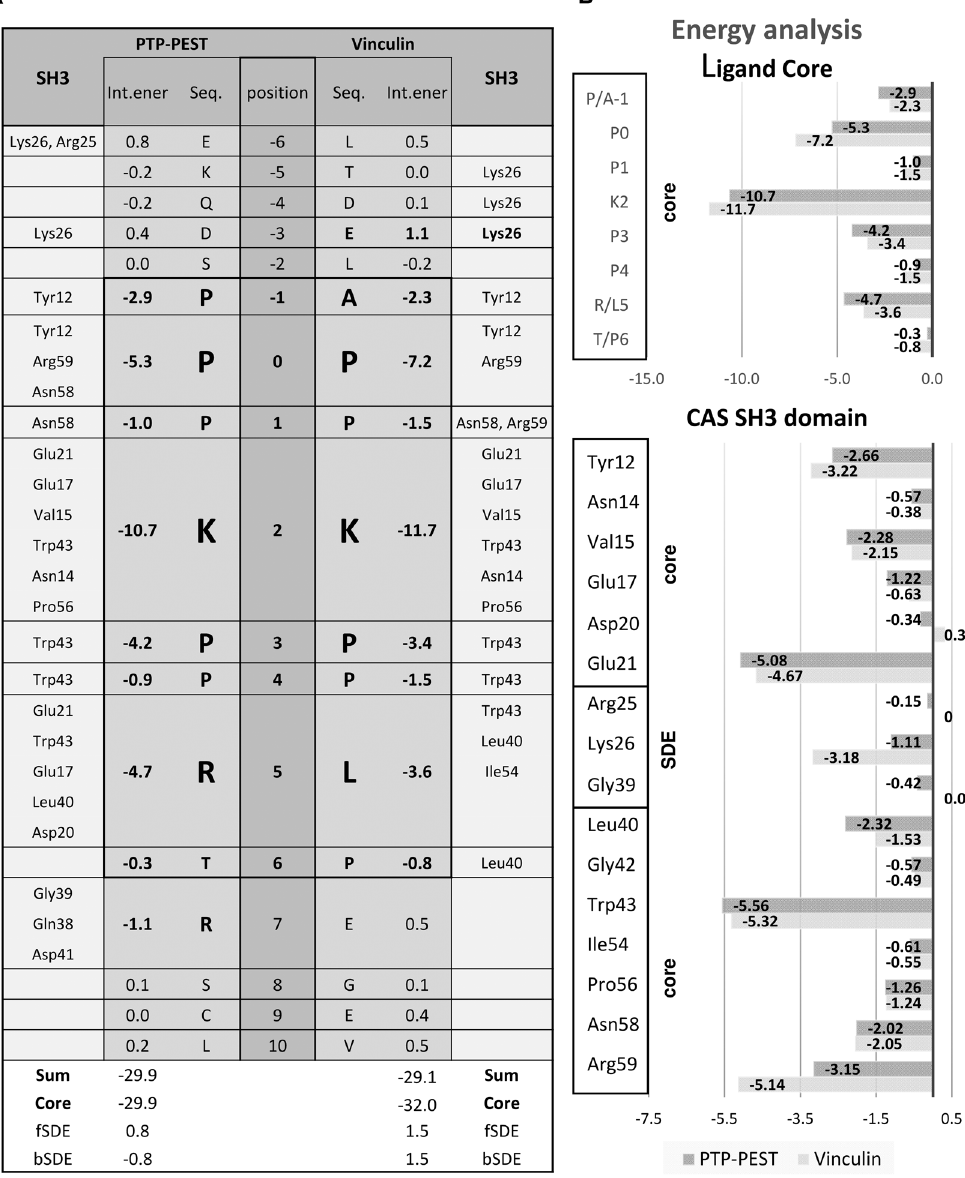
for PTP-PEST/Vinculin were determined in kcal.mol − 1 (Fig. 6A,B). The sums of the interaction contributions from the peptide residues (positions − 6 to 10) were − 29.9/ − 29.1. Nearly the entire interaction strength comes from the peptide core residues (positions − 1 to 6; the energy sums were − 29.9/ − 32.0). The largest contributions come from K 2 ( − 10.7/ − 11.7; Lys335/862), followed by P 0 ( − 5.3/ − 7.2; Pro333/860), R/L 5 ( − 4.7/ − 3.6; Arg338/ Leu865), and P